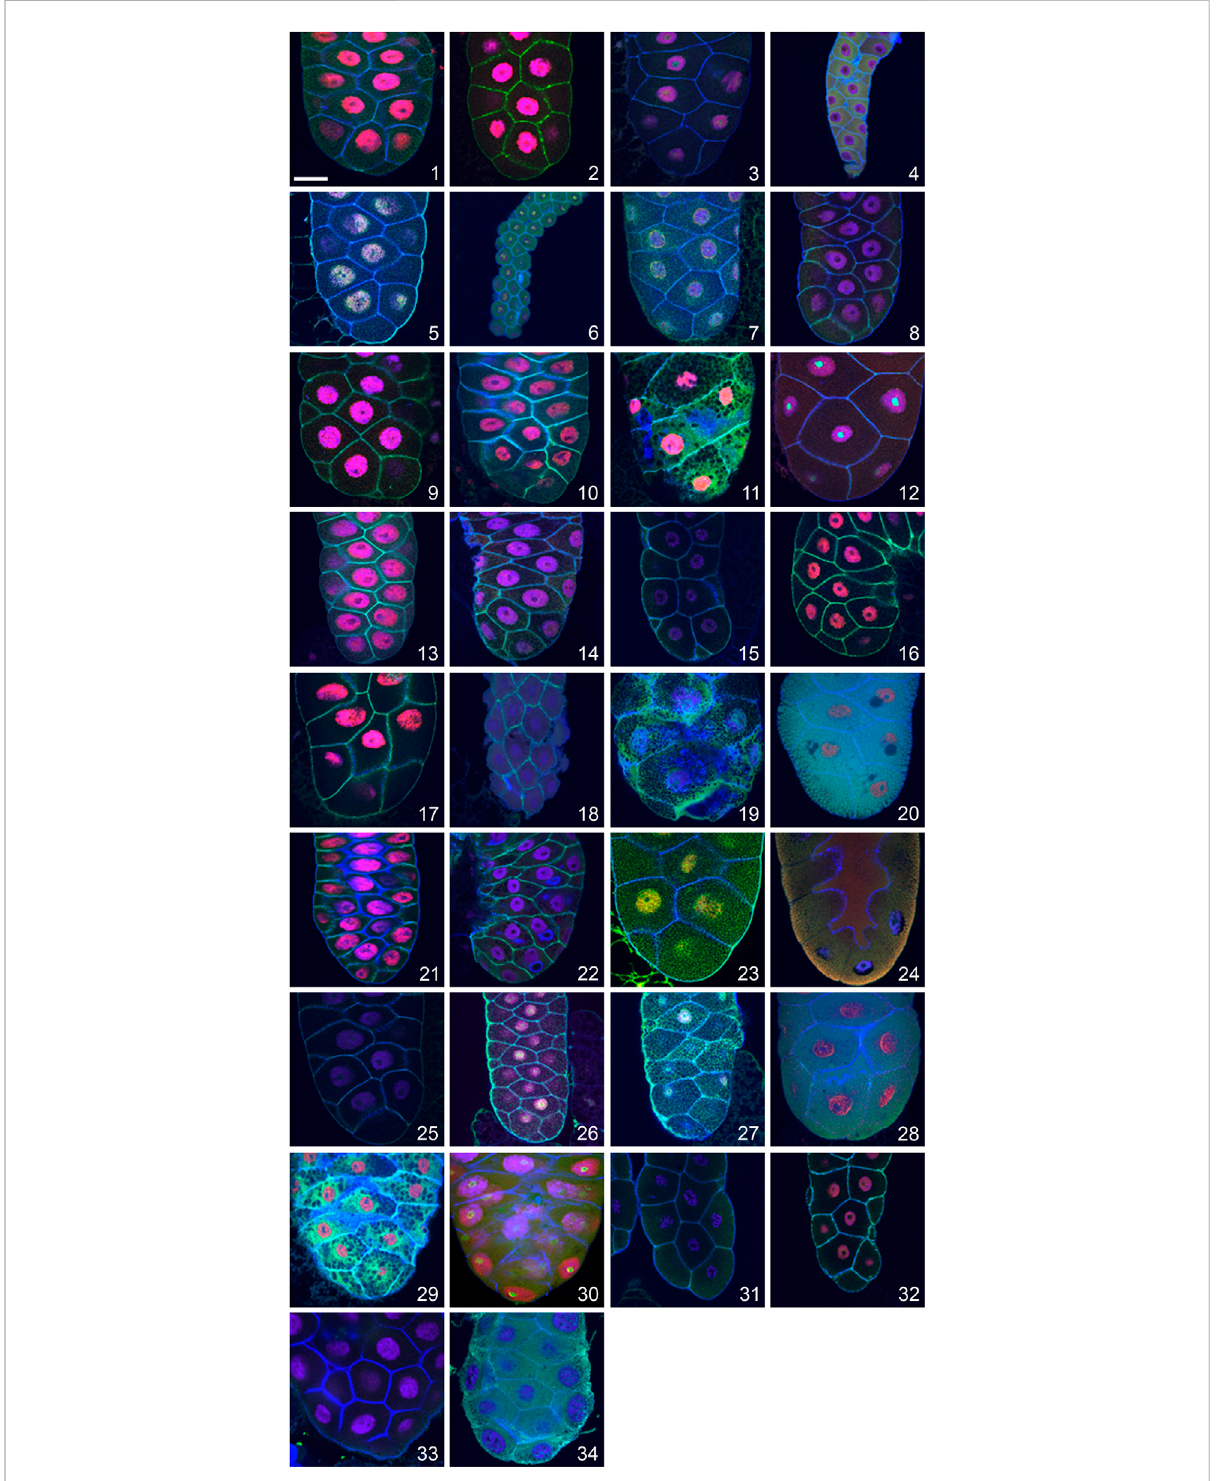
FIGURE 1 Visualization of late larval SGs of 32 Drosophila species and two unrelated dipteran species showing the presence and distribution of the transcription factor Broad-Complex (BR-C; red), the cytosolic cytoskeletal tumour suppressor protein p127 l(2)gl (green), fi lamentous actin (blue)